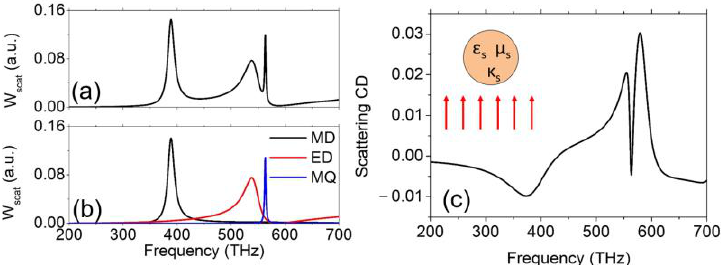
Figure 1. ( a ) The scattering spectrum of a chiral sphere with a radius of 75 nm under the illumination of linearly polarized light. The optical parameters of the sphere are 𝜀 𝑠 = 25 (permittivity), 𝜇 𝑠 = 1 (permeability), and 𝜅 𝑠 = 0.01 (chirality). The sphere is in free space (refractive index 𝑛 0 = 1). ( b ) The contributions to the total scattering energies from three different mechanisms (magnetic dipole, elec- tric dipole, and magnetic quadrupole). ( c ) The circular dichroism (CD) spectrum of 𝑔 scat under the illumination of left circularly polarized (LCP) and right circularly polarized (RCP) light.